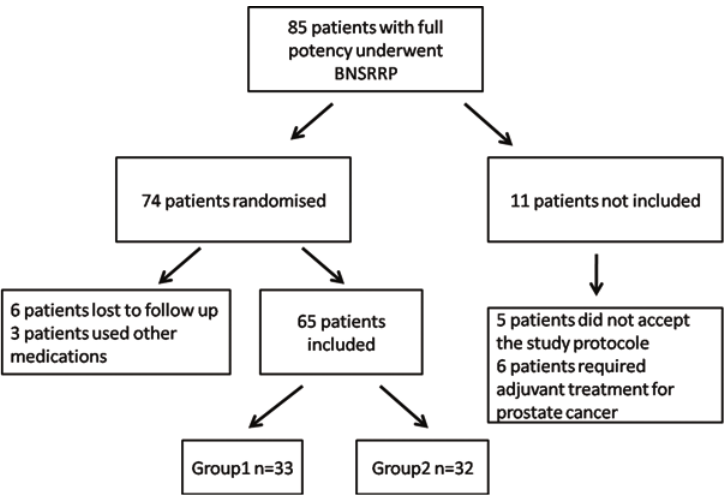
Figure 1 - Flow chart for the inclusion of the